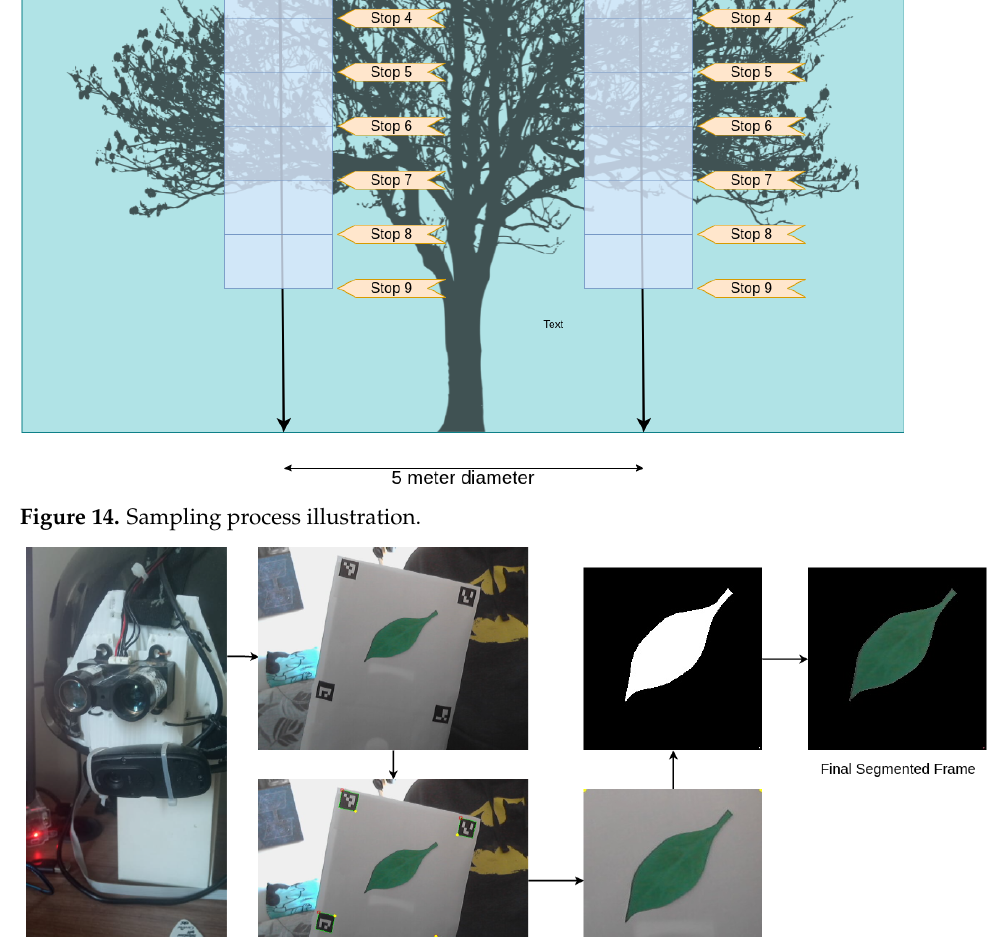
Figure 15. Demonstration of the segmentation process. The prototype used a USB camera to capture the data, which can be processed by the prototype itself or in the edge AI server